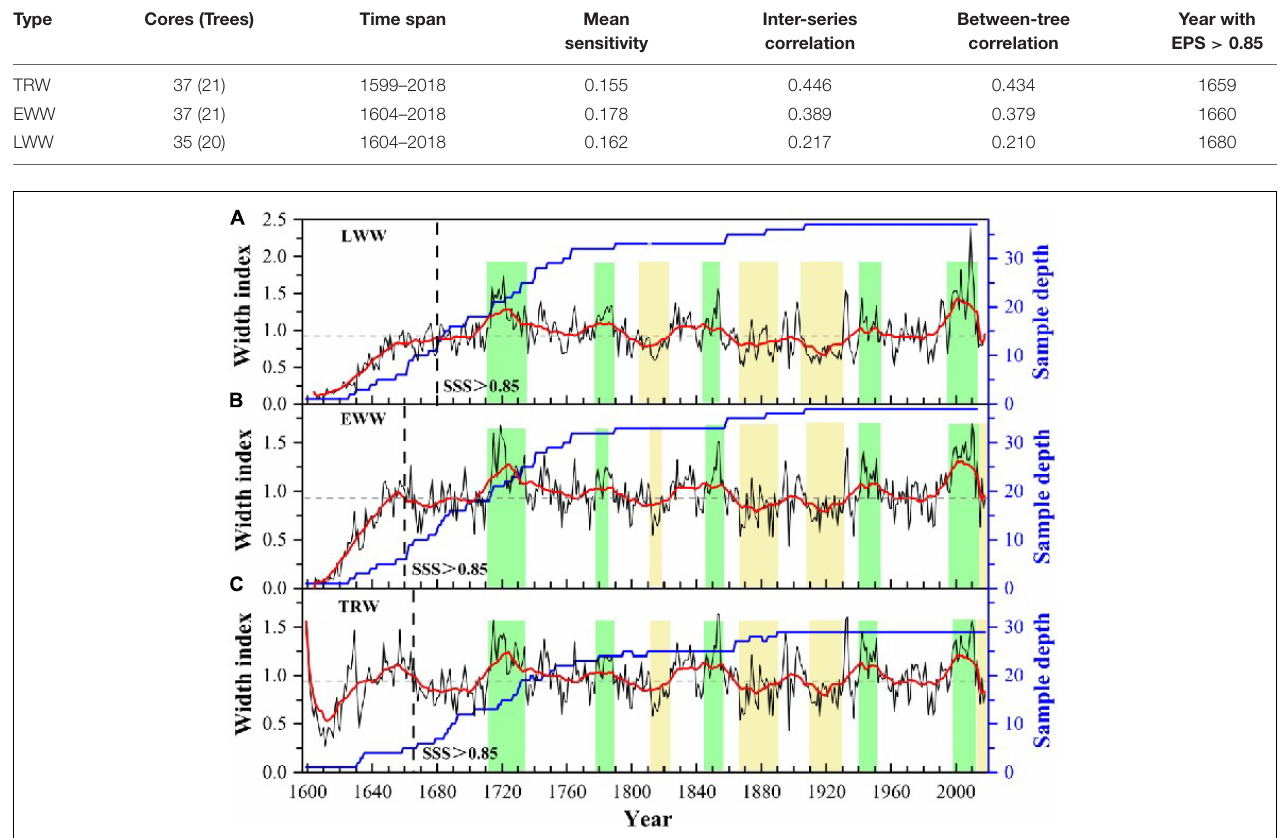
FIGURE 3 | Standard tree-ring indices and the sample depth at XQDV for (A) LWW (1680–2018), (B) EWW (1660–2018), and (C) TRW (1668–2018). Chronologies are smoothed by a 20-year running average (red curves). Yellow shading indicates years of suppressed growth (below the mean), and green shading indicates periods of rapid growth above the